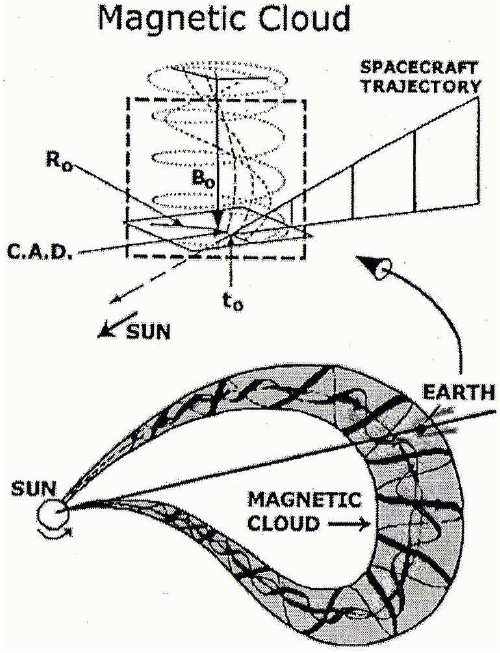
senting a MC locally, relative to the observing spacecrafts trajectory through it. Four model fit-parameters (R 0 , B 0 , t 0 , and closest ap- proach distance (C.A.D.)) of the total of seven are shown; φ A , θ A , (the MCs axial longitude and latitude, respectively) are two others, and handedness (H) is the last. In this case, if the thumb of the right hand is along the B 0 -direction and the fingers of that hand are par- allel to the direction of the tangential field at the boundary, then the MCs handedness is right-handed. If it took the left hand to satisfy these alignments with the fields, the MC is left-handed. (Bottom) A global representation of a MC and its relationship to the local spacecraft passage (after Marabashi, 1997; also see Burlaga et al., 1990).